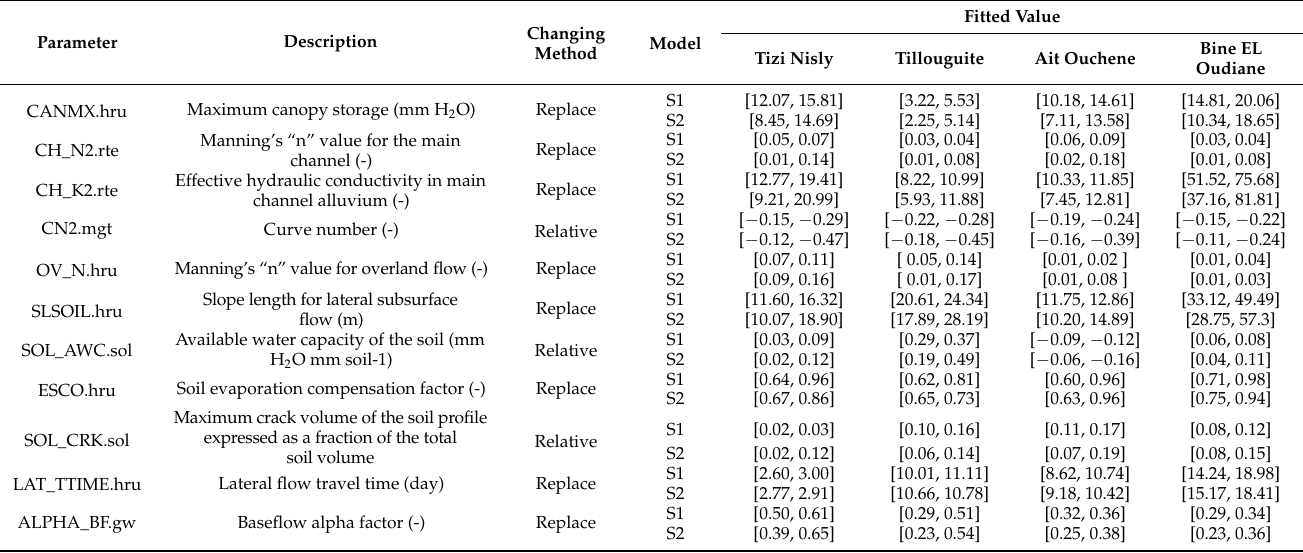
Table A3. Calibrated SWAT watershed parameters and their optimal